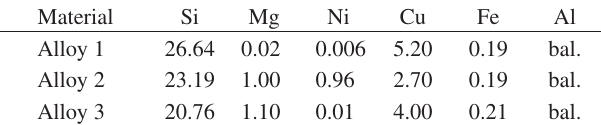
Table 1. Chemical composition of spray formed hypereutectic Al-Si alloys (mass %). The techniques used were atomic absorption spectrophotometry and Si gravimetry.